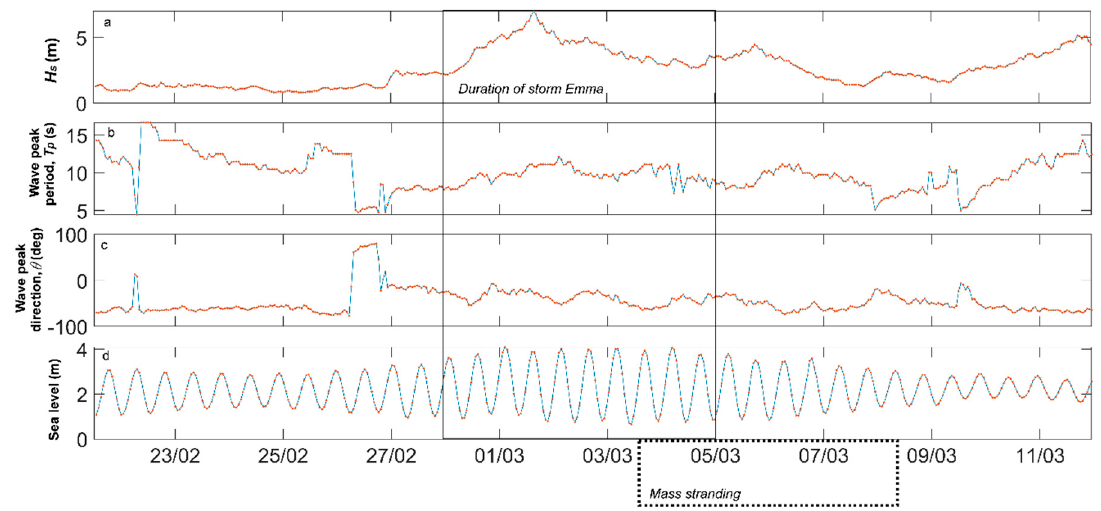
Figure 6. Oceanographic variables before and after the mass stranding of marine benthic animals: ( a ) Significant wave height, H s ; ( b ) wave peak period, T p ; ( c ) incident wave direction relative to shore normal, θ ; and ( d ) water level.